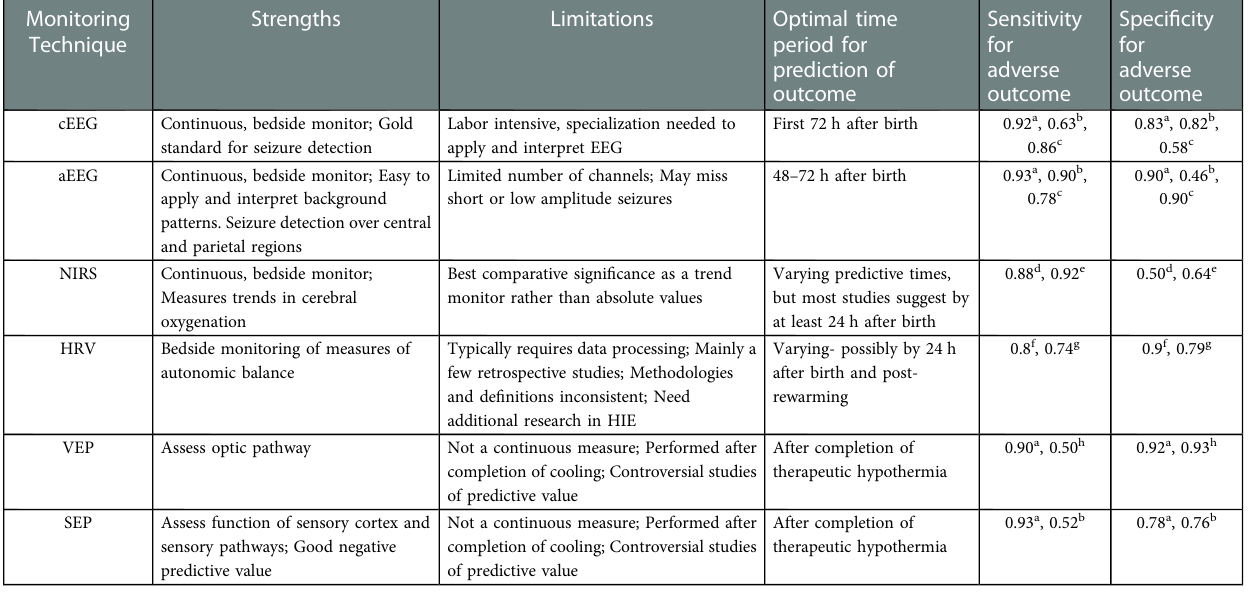
prognostication while undergoing therapeutic hypothermia. Neurologic exam and cerebral ultrasound performed poorly as predictors of outcome, with a large number of false positive